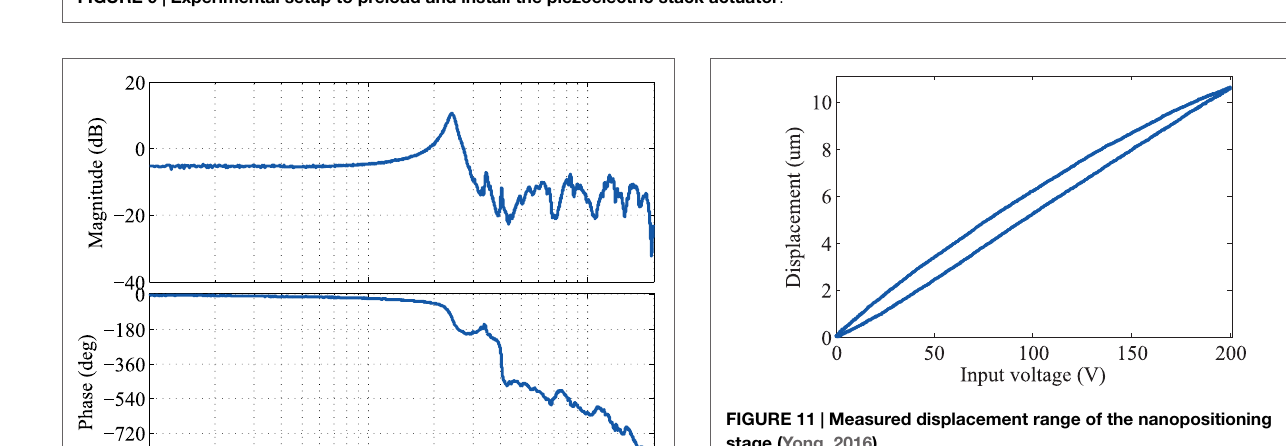
FIGURE 9 | Experimental setup to preload and install the piezoelectric stack actuator .